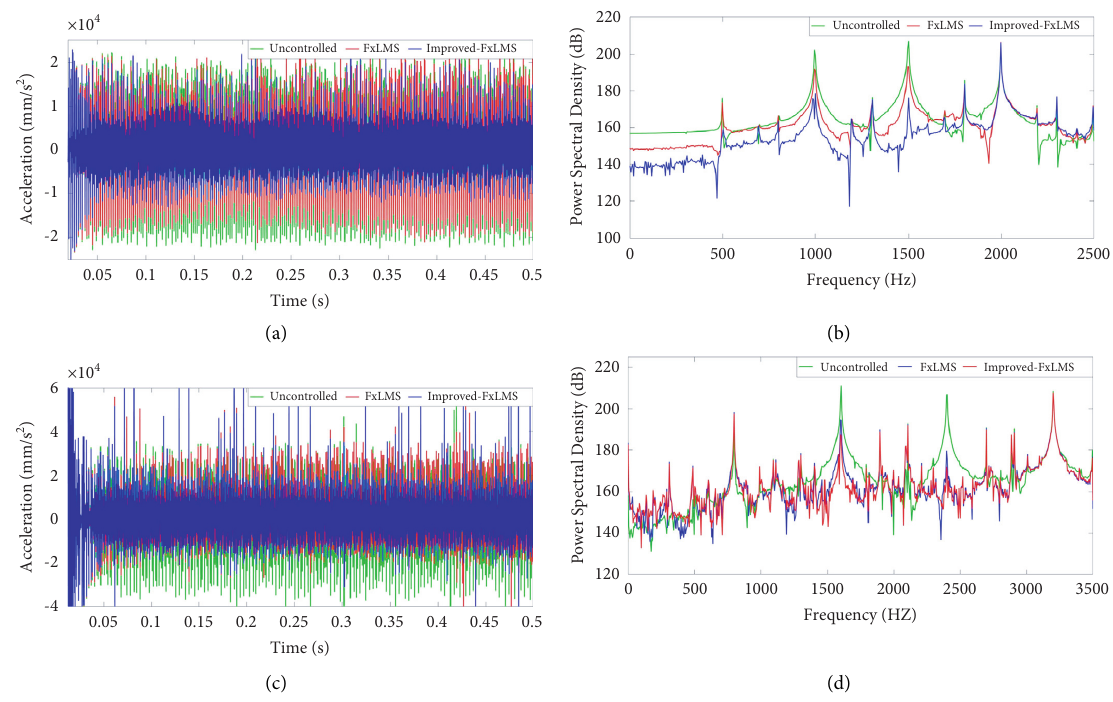
Figure 12: Simulation results of active vibration control. (a) Low-speed shaft time domain, (b) low-speed frequency time domain, (c) high- speed shaft time domain, and (d) high-speed frequency time domain.